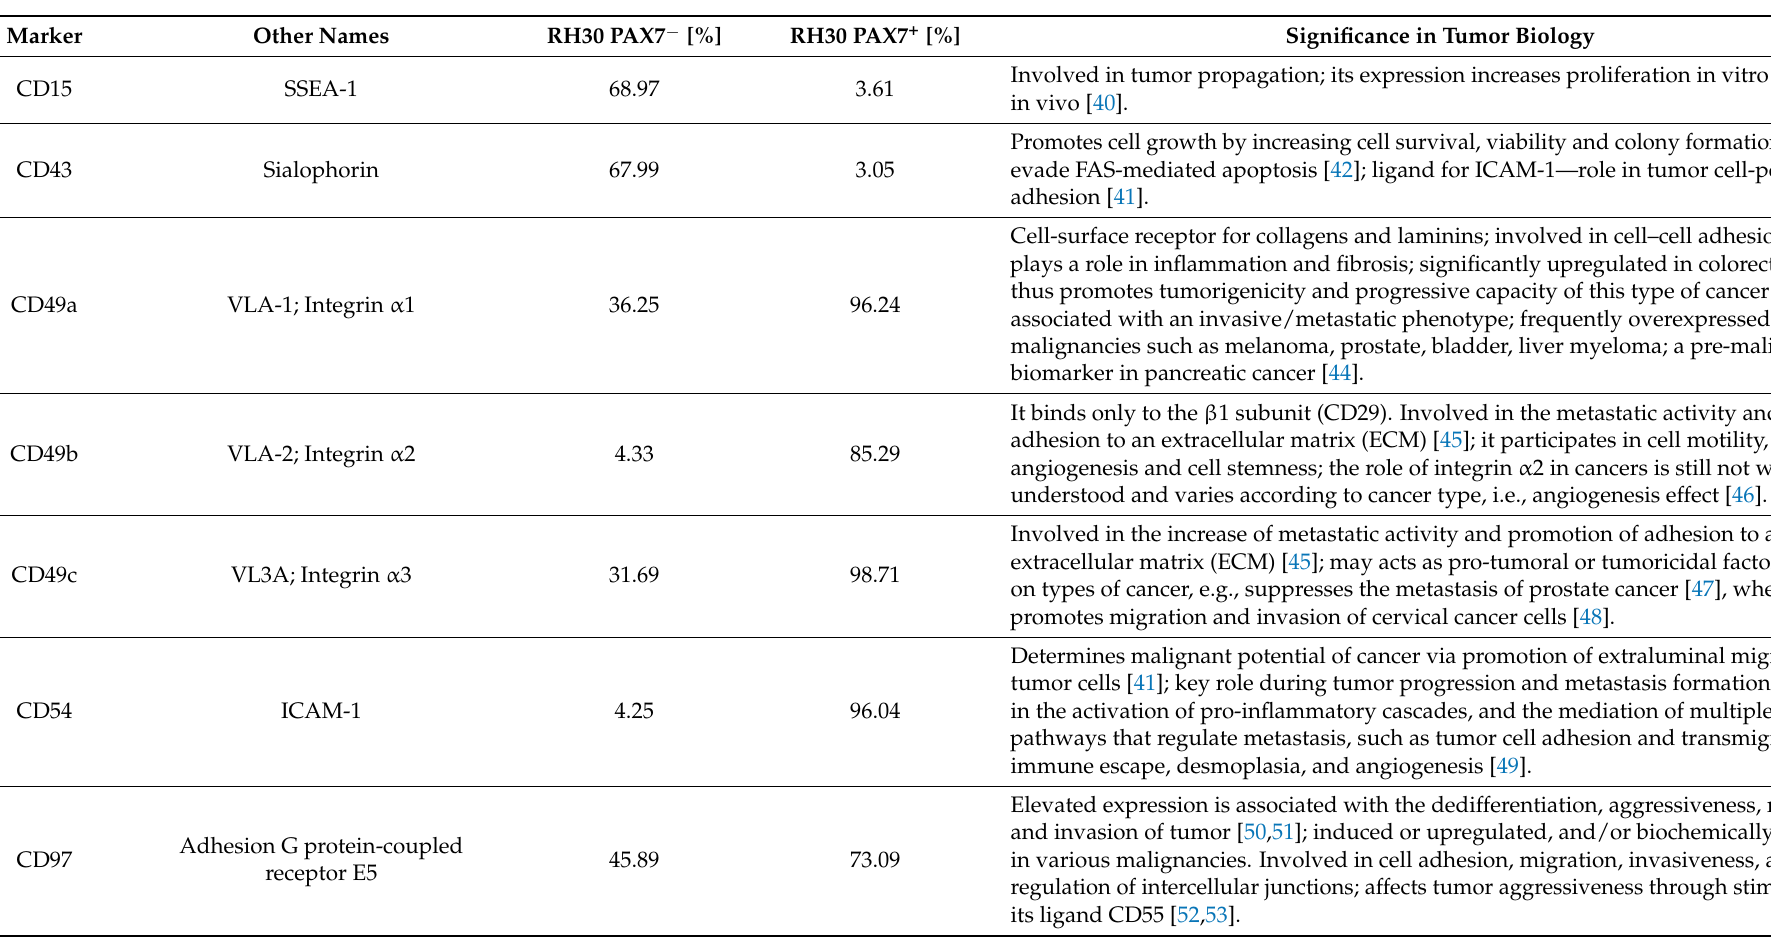
Table 2. Differences in expression of surface markers in RH30 PAX7 − and PAX7 + clones. The results are shown as the percentage of cells labeled with a Lyoplate Screening Panel (flow